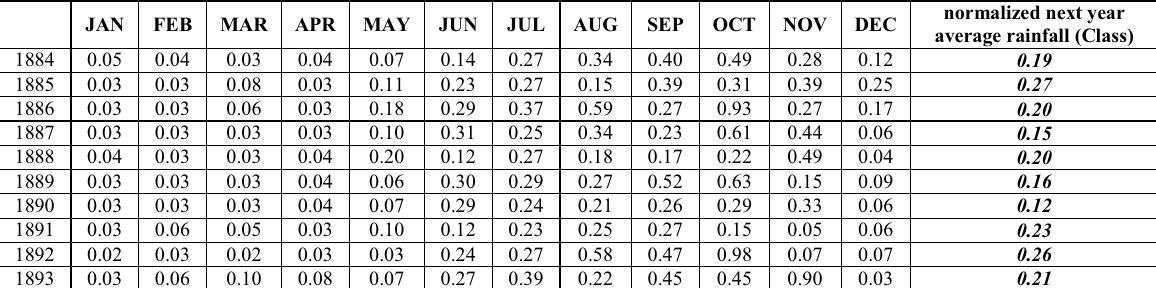
Fig. 2.Example rainfall dataset model of proposed rainfall prediction technique